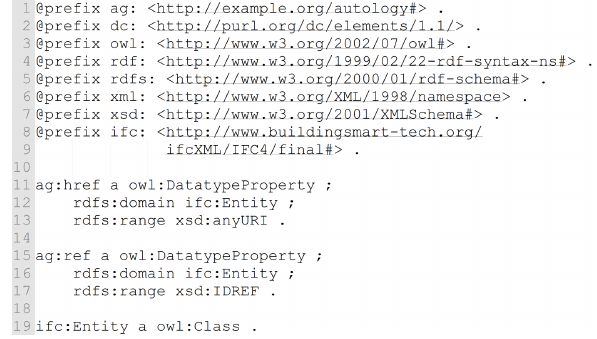
Figure 4. RDF/Turtle (.ttl) generated for Fig. 2 example